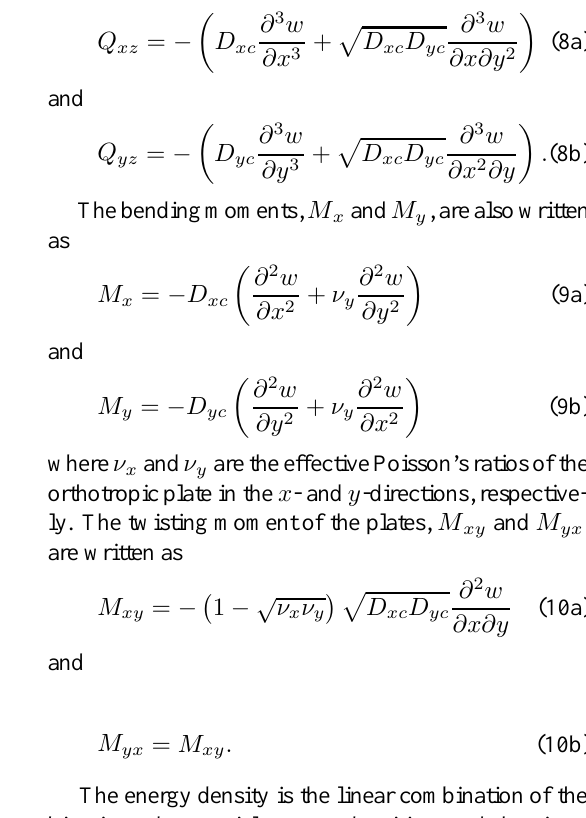
Fig. 5. The classical intensity field in the orthotropic plate when f = 500 Hz and η = 0 . 02 .